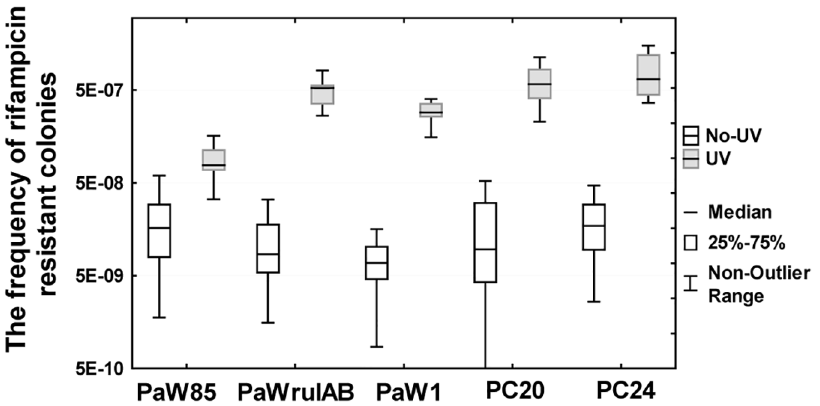
Fig 6. The comparison of spontaneous and UV-C irradiation (5 J/m 2 ) induced Rif r mutant frequencies. Each data representsthe median value from three replicate UV-mutagenesis assays. Data were analysed using the Mann-Whiteny U test (S9